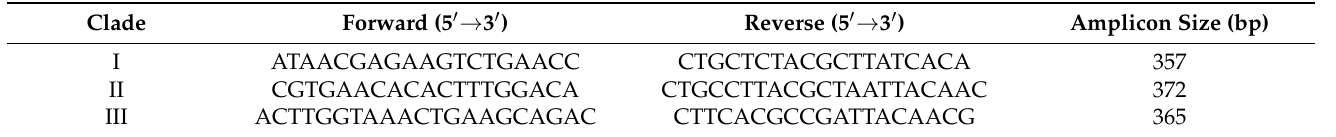
Table 2. Sequences of the clade-specific primer pairs designed in this